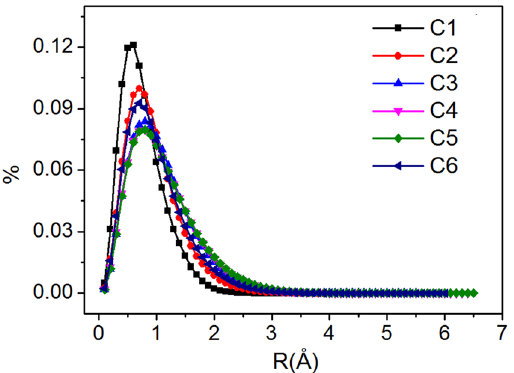
Figure 4. Distributions of displacement, with different systems: ( a ) CO 2 loading; ( b ) H 2 O loading; ( c ) temperature.